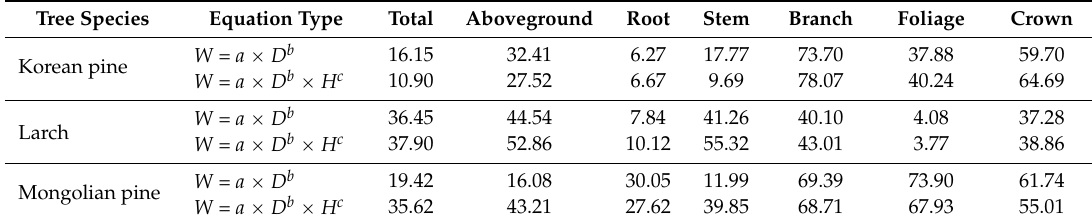
Table 3. Information statistic ( ∆ AICc) of likelihood analysis for two allometric biomass equations. Tree